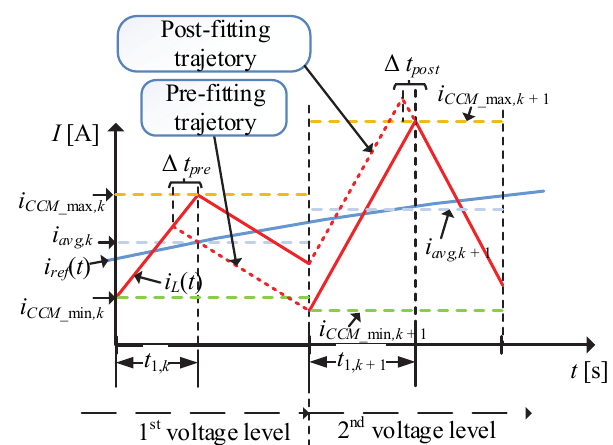
Fig. 3. Options for current fitting at transition between different voltage levels.